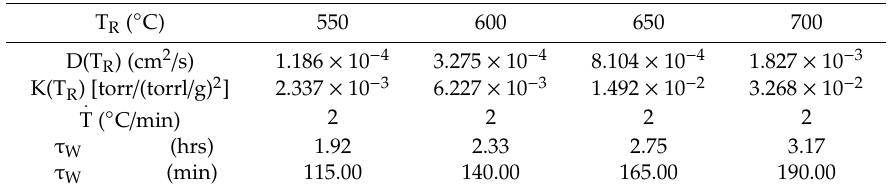
Table 4. Di ff usivity, Sieverts’ constant and warm up τ W of ST707 for di ff erent values of the regeneration temperature T R .